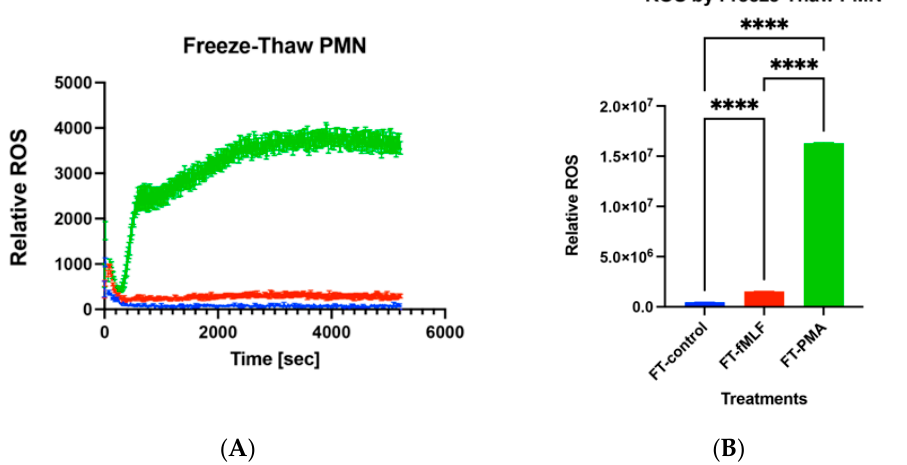
Figure 6. Reactive oxygen species production by freeze–thaw PMN. Freeze–thaw human PMN were loaded with Luminor and 100 nM fMLF (red), PMA (green), or buffer (blue) were applied to stimulate PMN to produce reactive oxygen species (ROS). Real time ROS production is shown in ( A ). Area under curve (AUC) for 5200 s was calculated to compare the ROS production ( B ). Experiments were done in quadruplicates. Mean and SE values are shown. *: denotes a significant difference by one-way ANOVA, Tukey. ****: p < 0.0001.